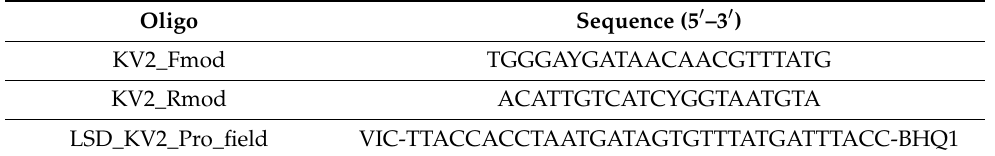
Table 1. Primers and probe for the KV-2 assay specific for wild-type strains of LSD virus.